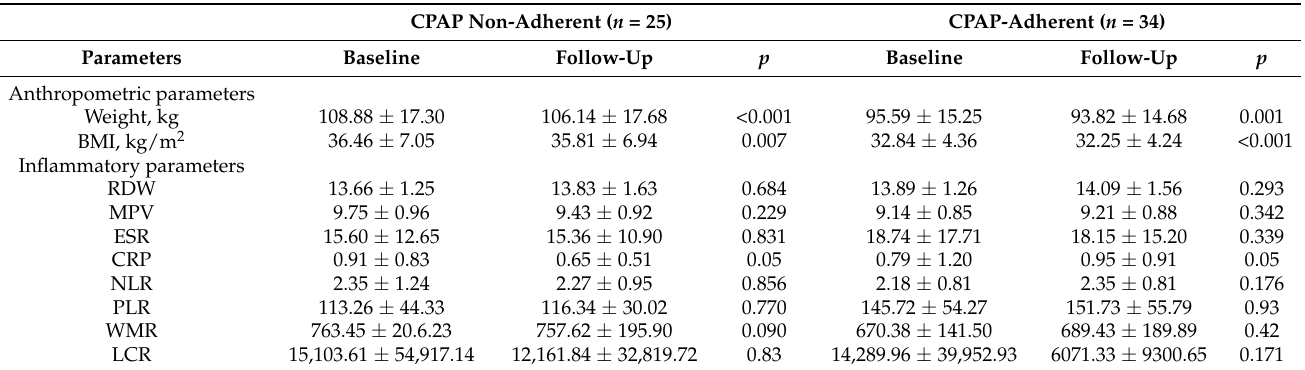
Table 4. Anthropometric and inflammatory parameters, at baseline and after 8 weeks of CPAP, in non-adherent and adherent subgroups.